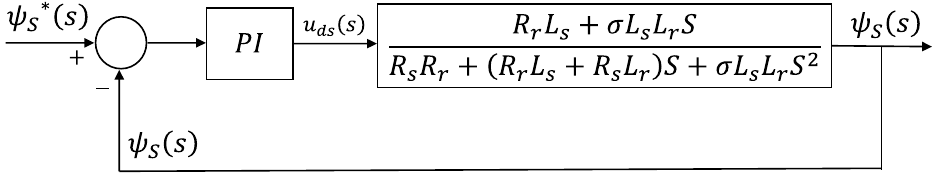
Figure 4. Stator flux block diagram.